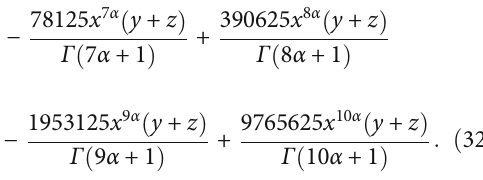
Figure 7: The absolute error between exact solution and tenth-order approximate solution: (a) α = 2 and (b) α = 1 : 8 .